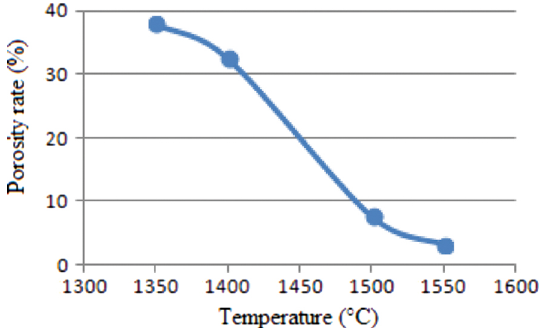
Figure 1: The porosity rate of samples obtained at different temperatures.